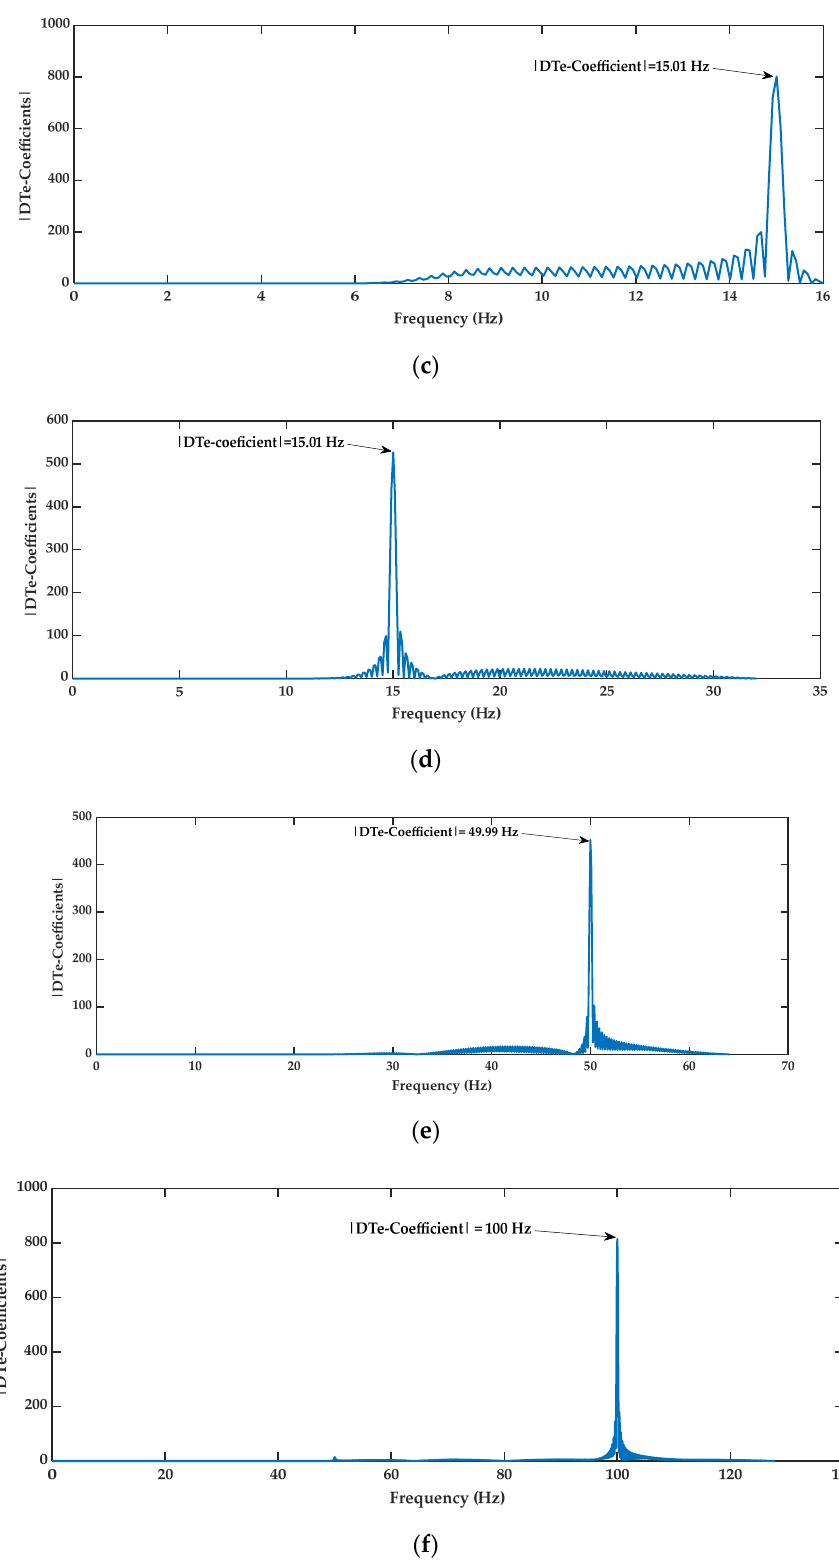
Figure 4. Analysis of a signal in the Te domain. ( a ) Decomposition level 6. Estimation error N/A. ( b ) Decomposition level 5. Estimation error N/A. ( c ) Decomposition level 4. Estimation error 0.06%. ( d ) Decomposition level 3. Estimation error 0.06%. ( e ) Decomposition level 2. Estimation error 0.02%. ( f ) Decomposition level 1. Estimation error 0.01%.